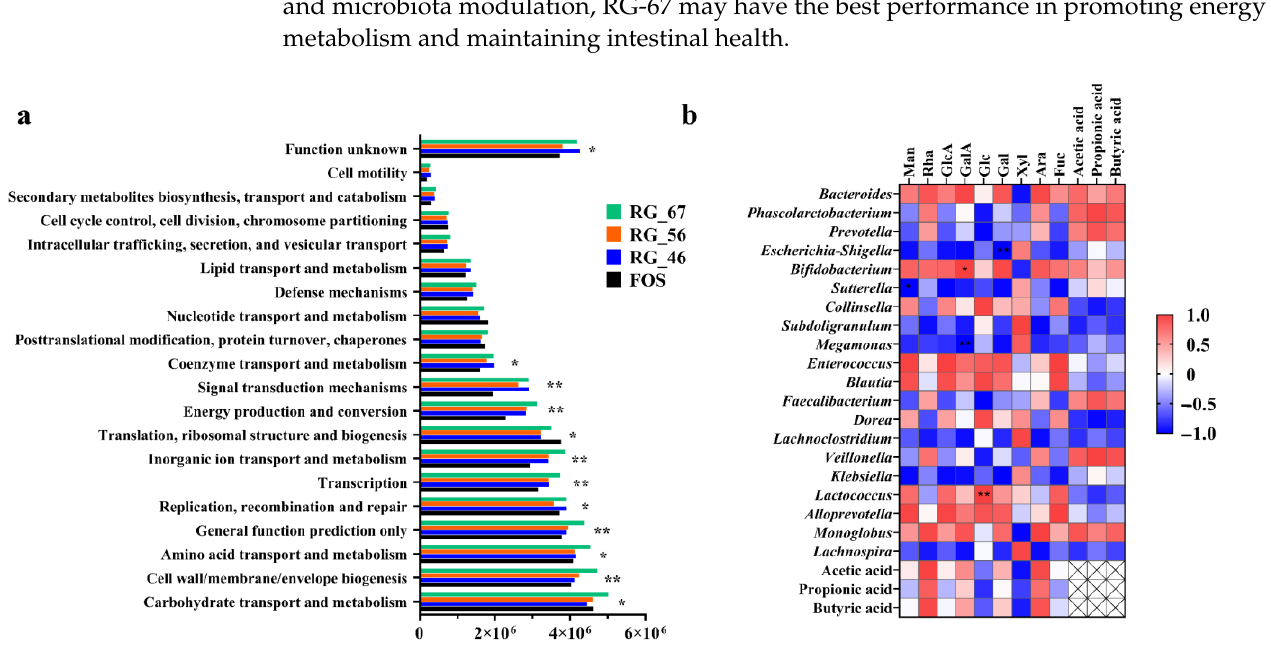
Figure 5. Results of PICRUSt function prediction analysis and Pearson correlation analysis. ( a ) Clusters of orthologous groups (COG) function annotation analysis; ( b ) the heatmap result based on Pearson’s correlation coefficient among monosaccharides, SCFAs, and the relative abundances of bacteria at the genus level. Statistically significant differences are shown with asterisks, as follows: (*) p < 0.05 and (**) p < 0.01.